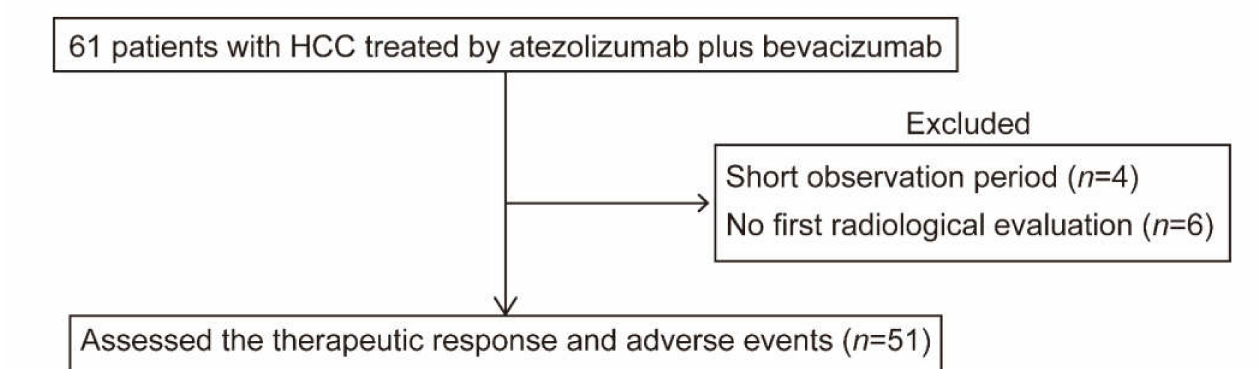
Figure 1. Flow diagram of the